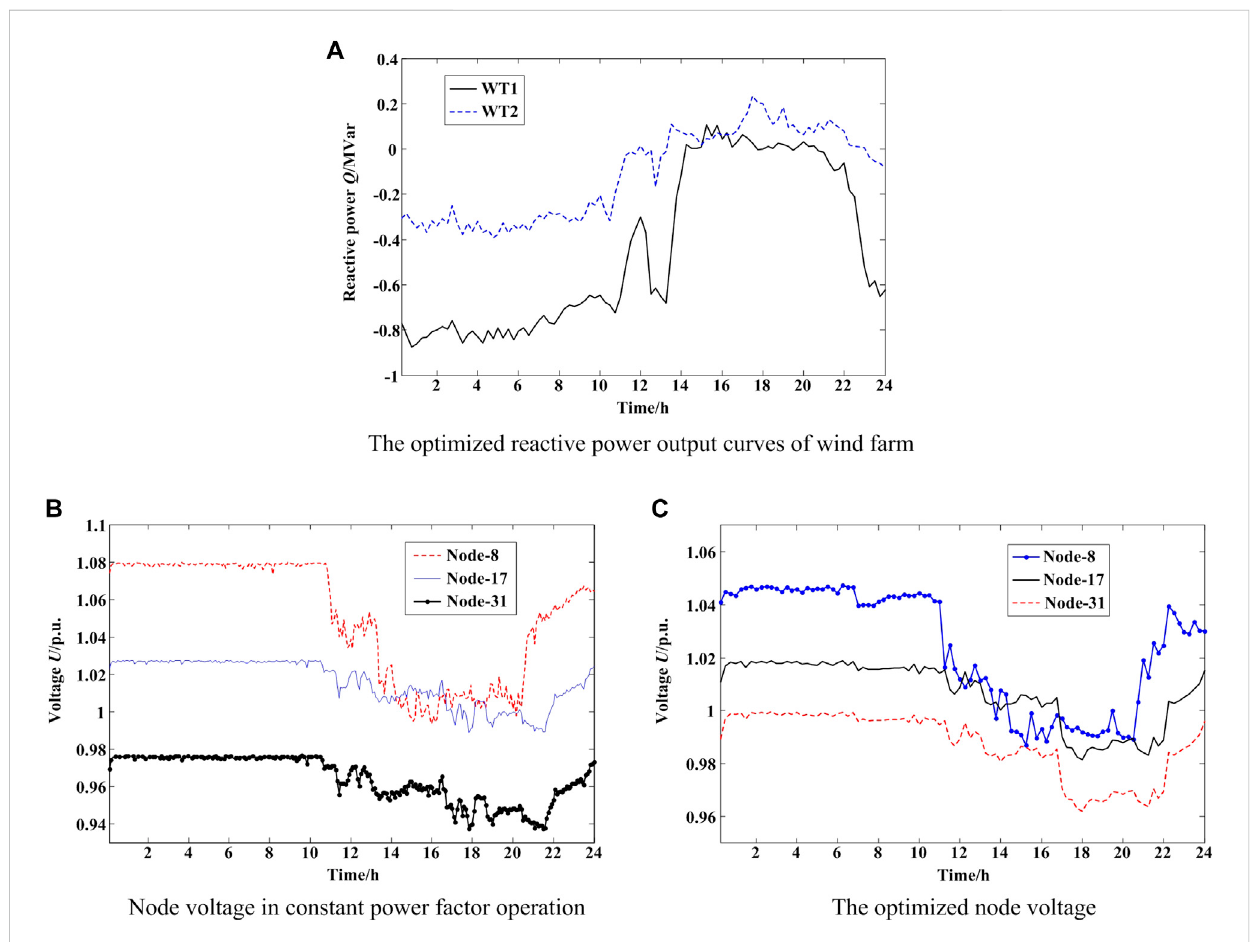
FIGURE 12 Diagram of optimization